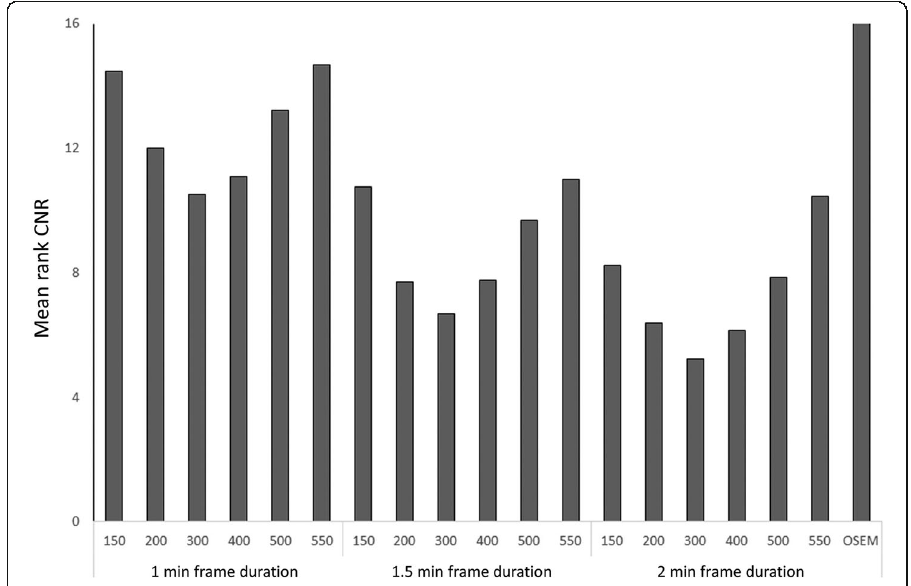
Fig. 2 Mean rank of CNR in pathologic lymph nodes. Ranks (1 – 19 where 1 is the best) were calculated for all patients and then averaged